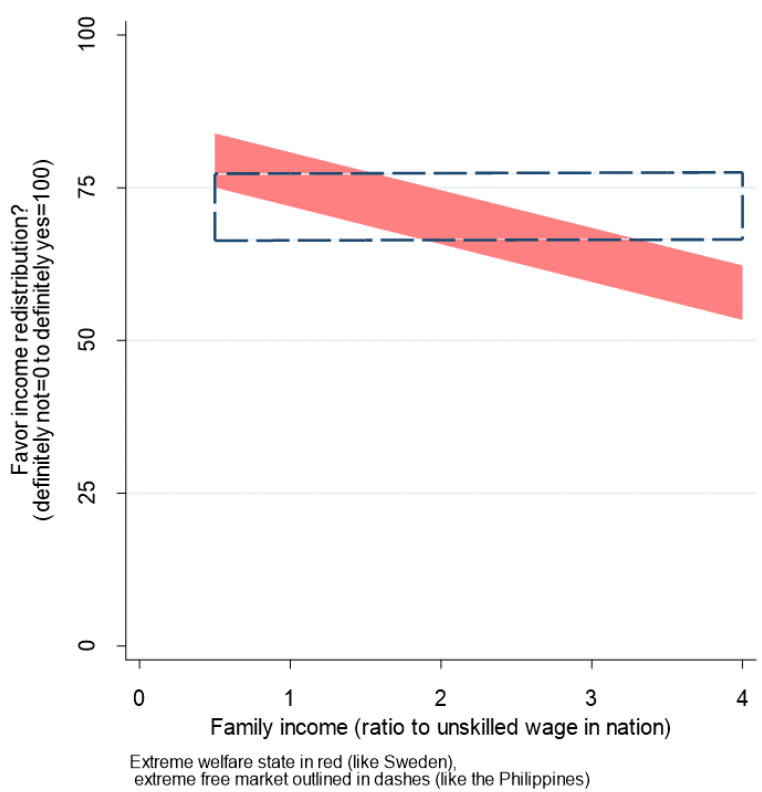
Figure 17. Differences between rich and poor in attitudes towards income redistribution. 95% confidence intervals from multilevel regression controlling for age, gender, education, and GDP. However, the experience of their more prosperous peers is very different.